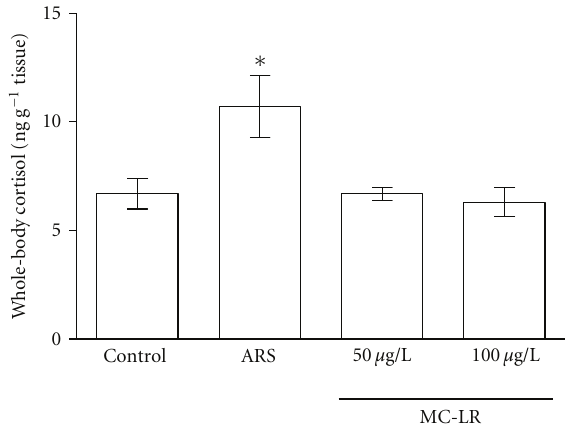
Figure 3: E ff ect of exposure to microcystin-LR on whole-body cortisol levels. Data expressed as men ± SEM. n = 7. One-way ANOVA/Newman-Keuls post hoc test. ∗ P < 0 . 05 compared to control